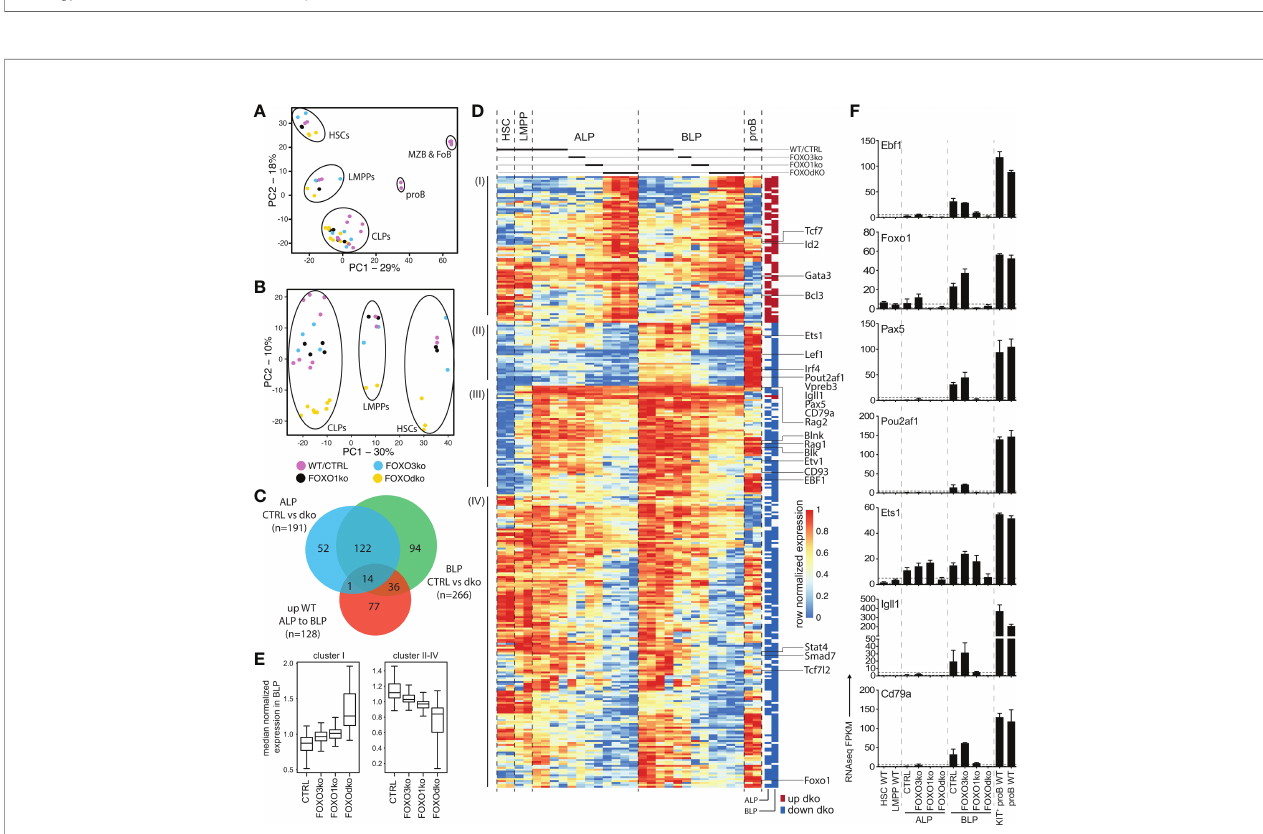
FIGURE 4 | FOXOdko CLPs maintain cellular identity but fails to up-regulate B lineage related genes. (A, B) Principal component analysis of RNAseq data. (C) Venn diagram displaying the overlap between genes differentially expressed (Bonferroni corrected p-value <0.05 and 2-fold difference comparing FOXOdko to CTRL and ≥ 30 reads in at least two samples) in the FOXOdko at the indicated CLP stage or in the ALP to BLP developmental transition. (D) Hierarchical clustering of expression for genes displaying differential expression in FOXOdko CLPs. The stage where a signi fi cant change occurs is indicated to the right. (E) Median normalized expression of genes within clusters I and cluster II-IV from panel (D) . (F) Expression of indicated